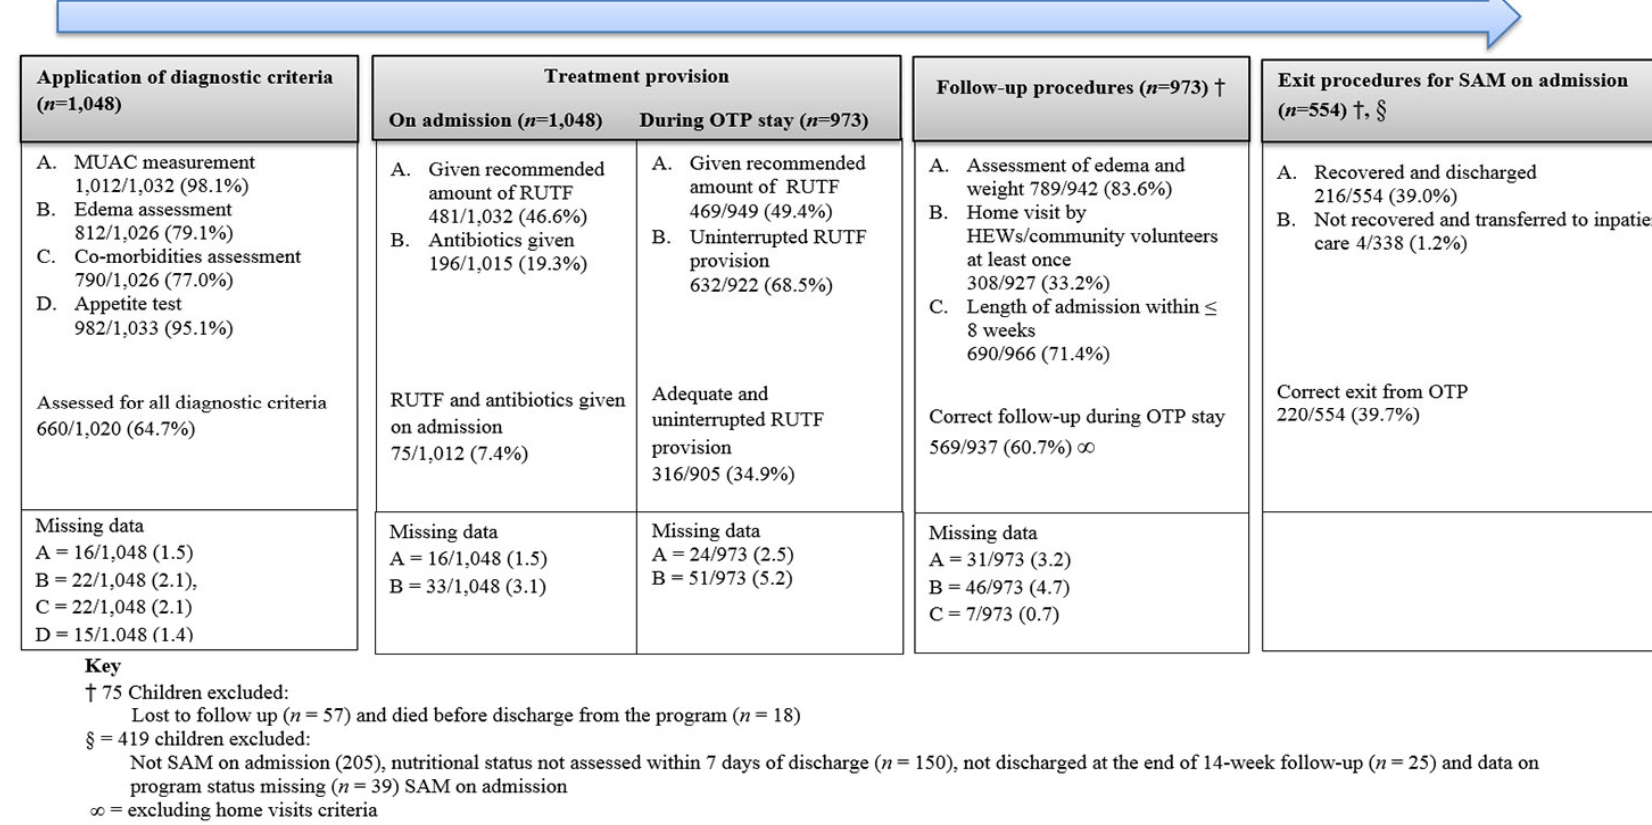
Figure 2. The critical steps in management of Severe Acute Malnutrition (SAM) in a scaled up and integrated OTP.